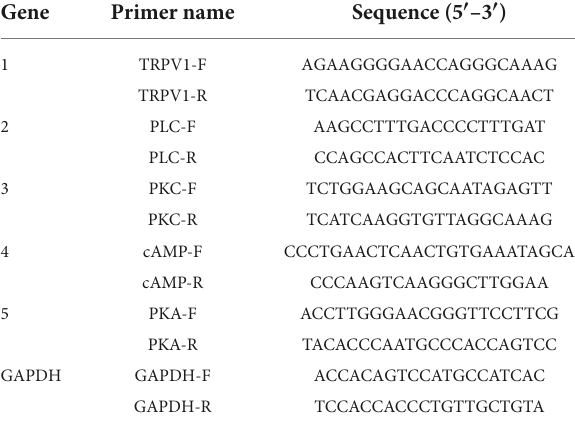
TABLE 4 qRT-PCR